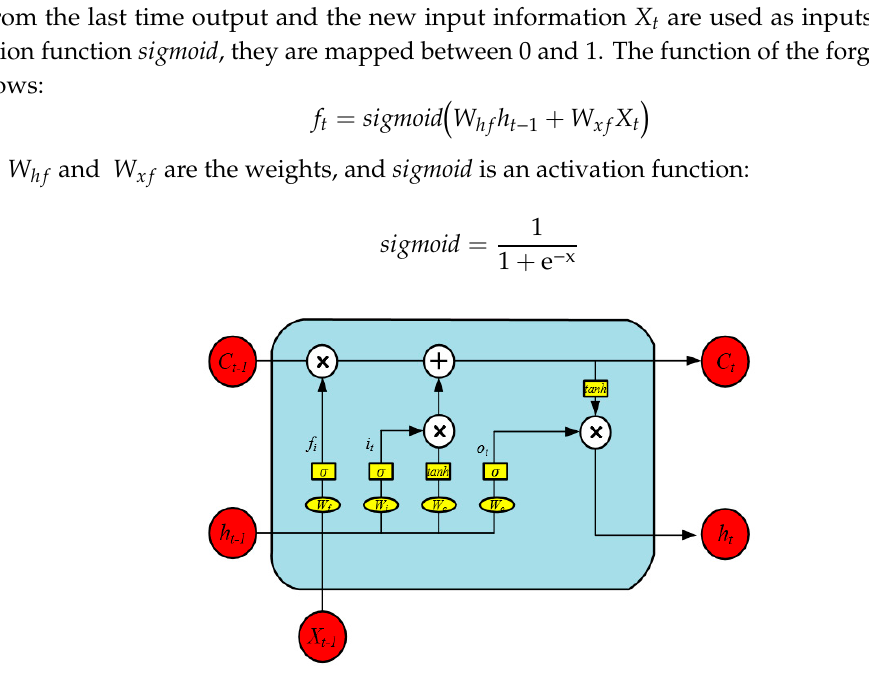
Figure 4. Structure of the long short-term memory (LSTM) algorithm.